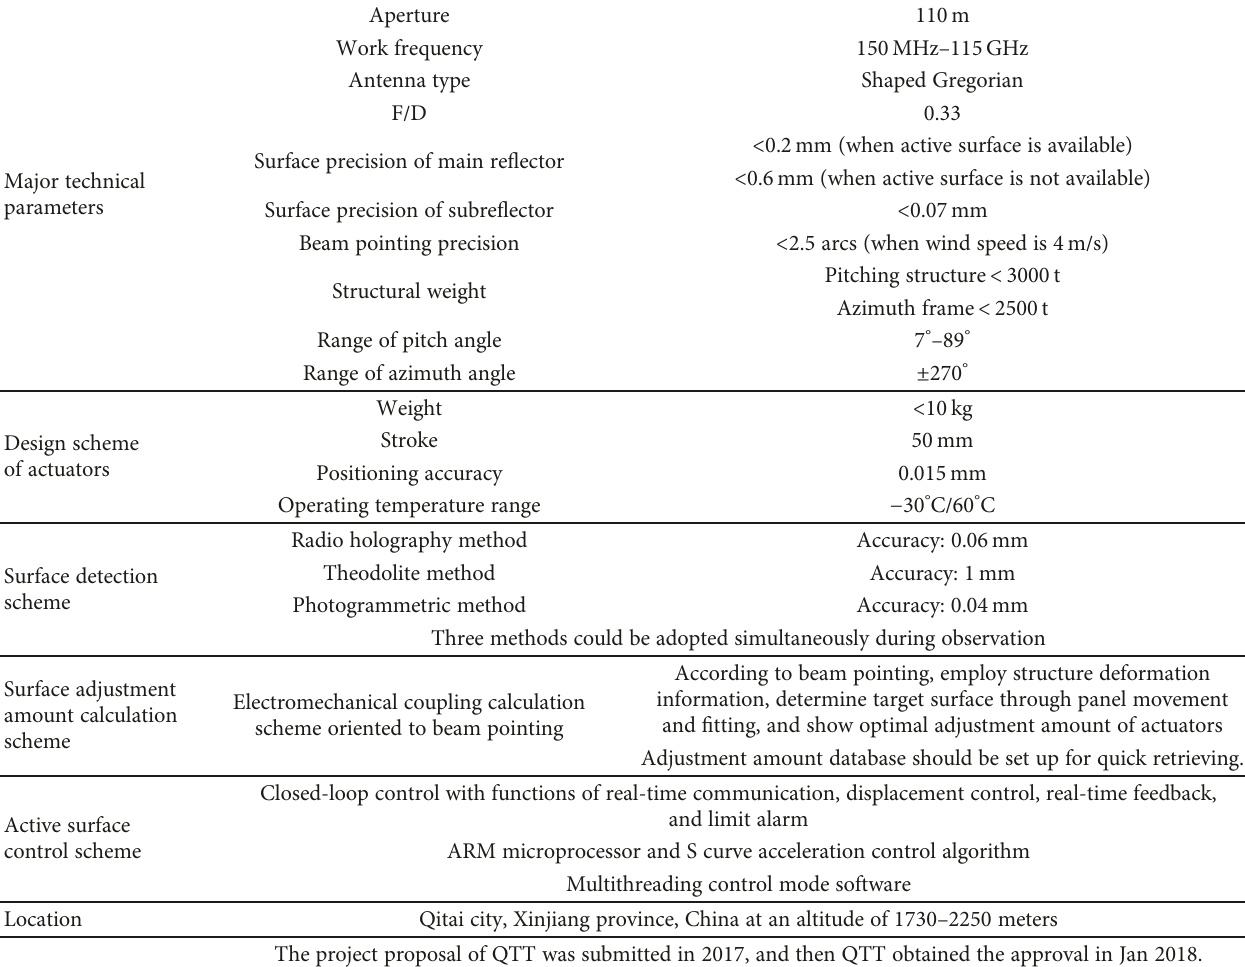
Table 9: Critical performance parameters and design options for